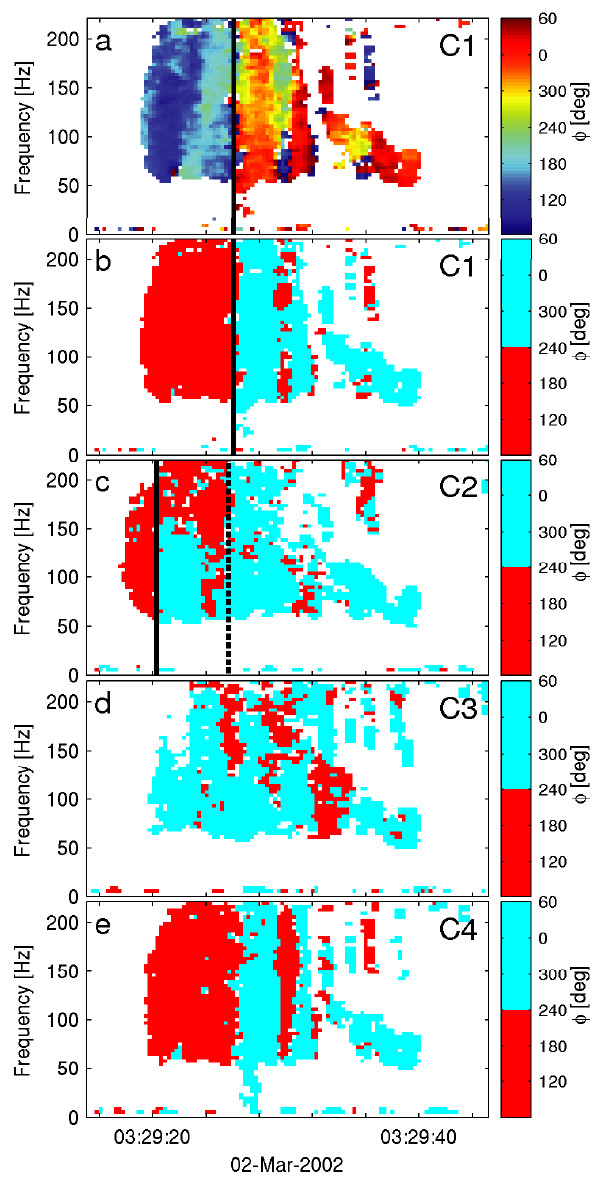
Fig. 6. The azimuthal angle, φ , versus time and frequency for the four spacecraft. The vertical lines in the panels for C1 and C2 cor- respond to the lines in Fig. 4. Hence, the shifts in azimuthal angle coincide with the centers of the bands of more anti-parallel waves.